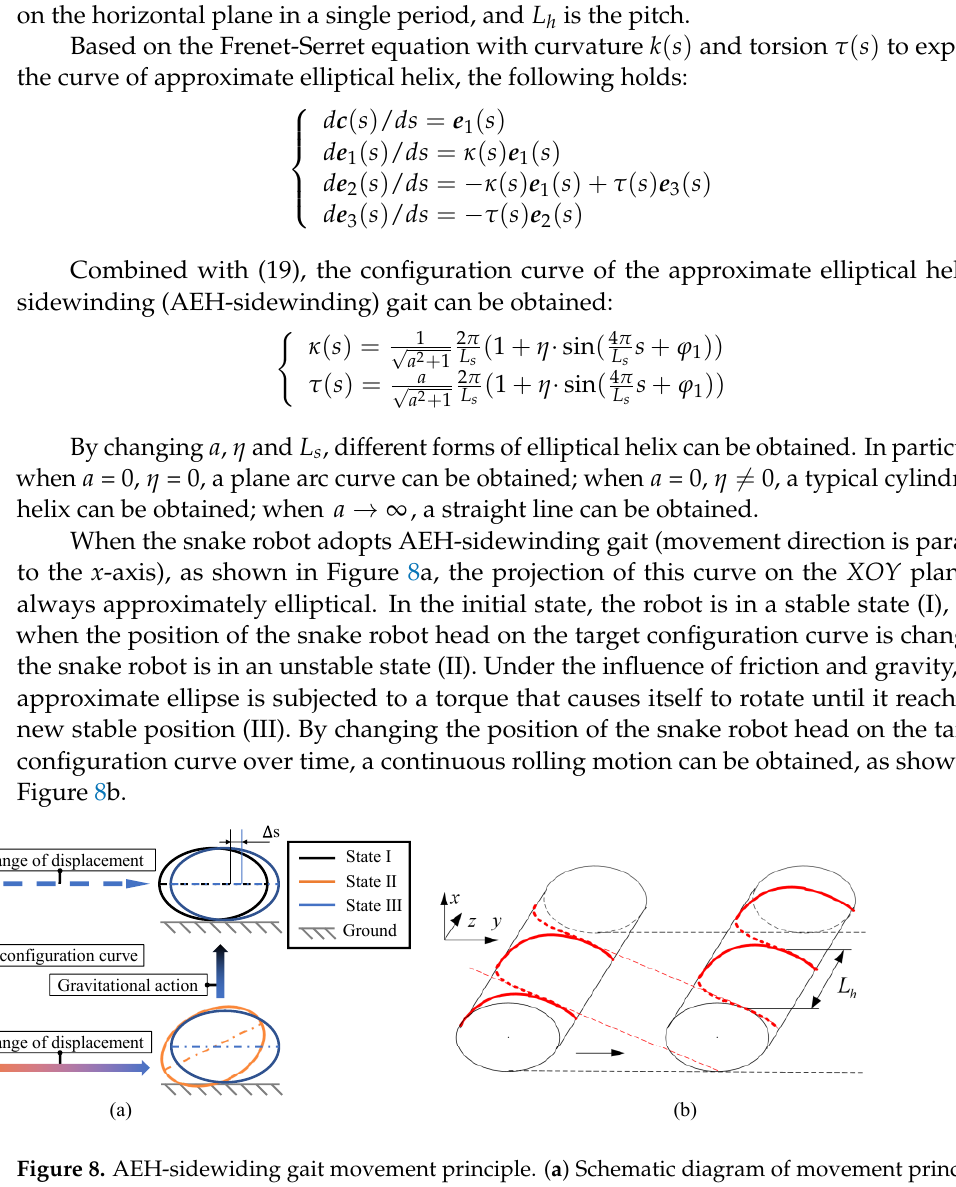
Figure 9. Implementation of snake robot with AEH-sidewinding gait. The figure shows the motion state of a snake robot at t = 0 s, t = 1 s, t = 2 s, and t = 3 s, respectively. 5. Conclusions In this paper, a new gait generation method of snake robots, the MCC method, is proposed. By abstracting the low-order sine factor of the backbone curve of snake robots, the unified control expression function of various gaits is obtained. Serpentine gait, rolling gait, helix rolling gait based on parameterized gait generation method, and crawler gait based on scripted gait generation method are reconstructed by the MCC method. In addi- tion, for the mismatch between the traditional side-winding gait and the kinematics mod- eling of the side-winding gait based on the assumption of ideal elliptic helix, an AEH- sidewinding gait with a back curve closer to the ideal elliptic helix is proposed and veri- fied by experiments. This unified gait expression of snake robot will be helpful to realize smooth gait switching between different gaits of snake robot. Author Contributions: Conceptualization, C.T., G.Z. and L.S.; methodology, C.T., L.S.; software, X.S.; validation, H.T., H.W.; formal analysis, L.S.; investigation, L.S. and X.S.; resources, C.T. and G.Z.; data curation, H.T. and H.W.; writing — original draft preparation, C.T. and L.S.; writing — review and editing, C.T.; visualization, L.S.; supervision, G.Z.; project administration, G.Z.; funding